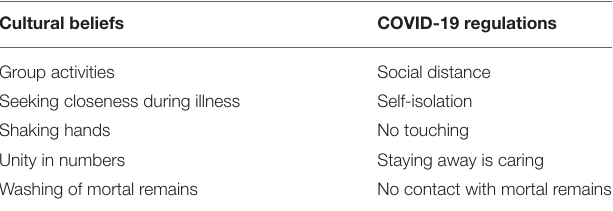
TABLE 1 | Contrast between common social practices and COVID-19 regulations. Cultural